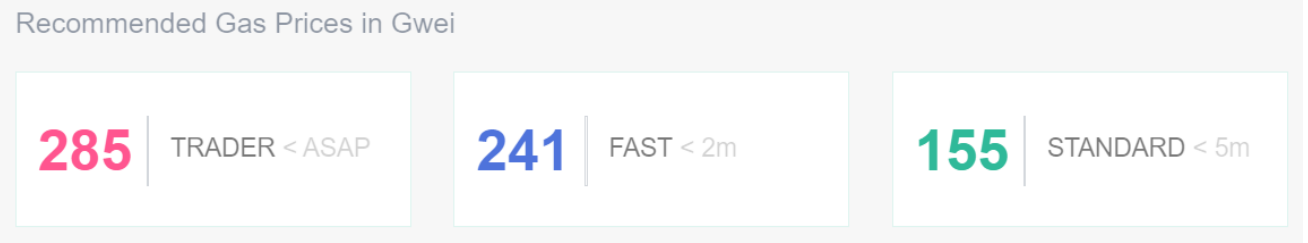
Figure 21. The recommended gas price as of 4 February